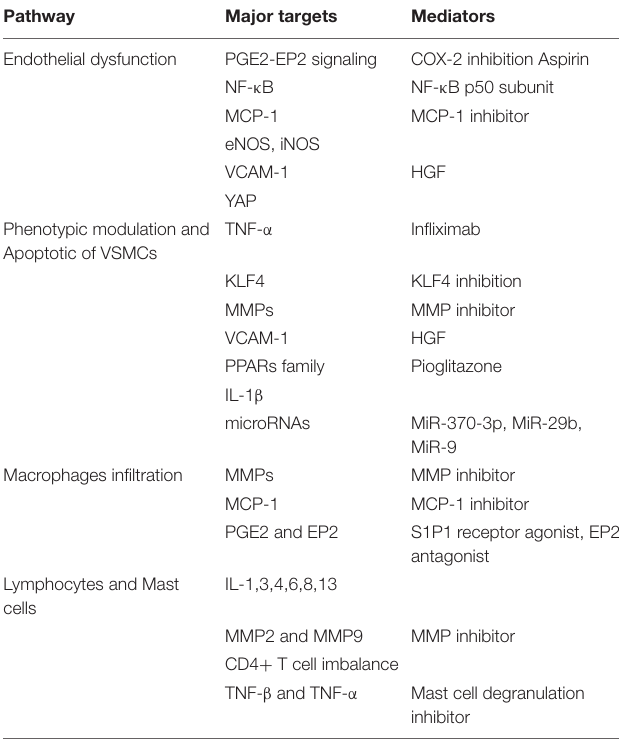
TABLE 1 | Targeted therapies for intracranial aneurysms (IAs).